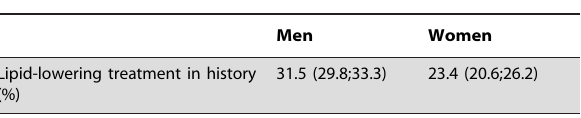
Table 1. Characteristics of the study population at baseline and at follow-up.